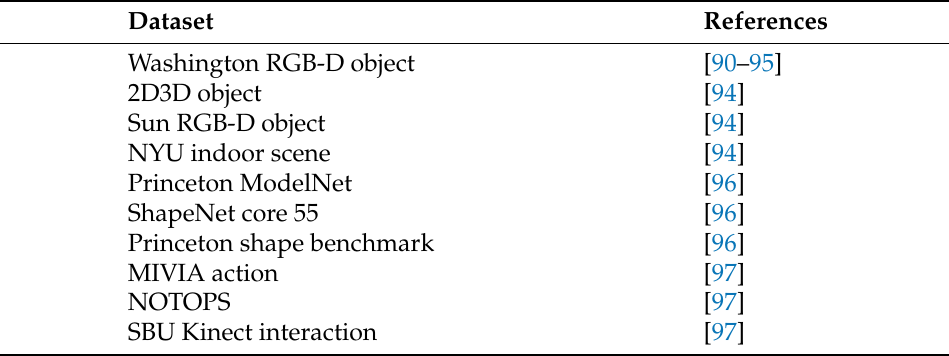
Table 7. The datasets for RGB-D image recognition reported in the primary studies.